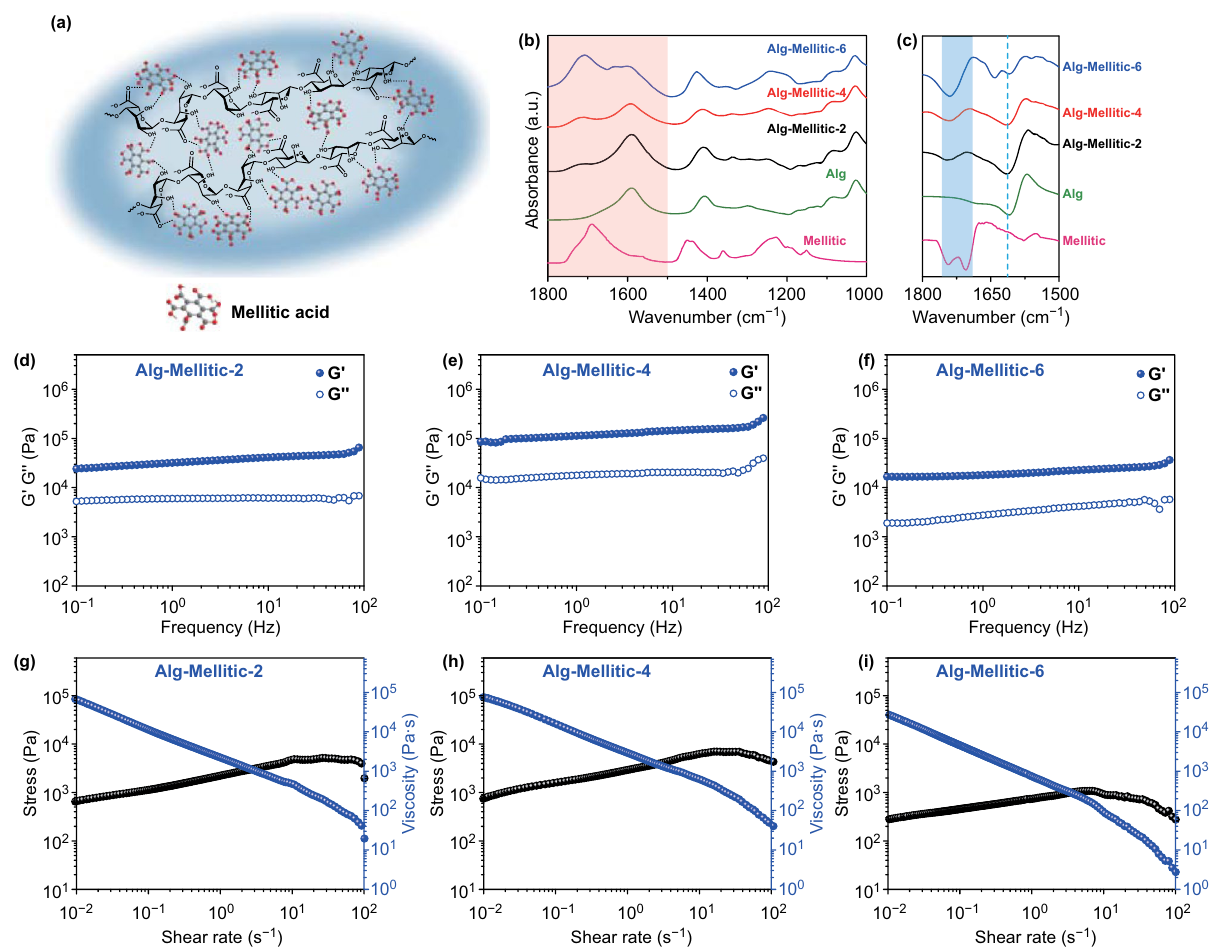
Fig. 2 Properties and printability of the precursor inks. a Schematic structure of the multiple molecule interactions between ligand mellitic acid and sodium alginate. b FTIR spectra of the mellitic acid, sodium alginate, Alg-Mellitic-2, Alg-Mellitic-4 and Alg-Mellitic-6 in the regions of 1800–1000 cm −1 , respectively. c Corresponding second derivative curves in the regions of 1800–1500 cm −1 . d – f Storage (G ′ ) and loss (G ″